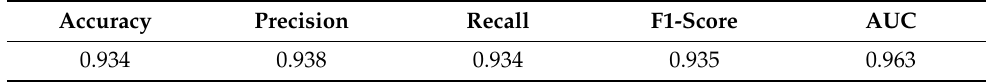
Table 3. Performance of classification model.